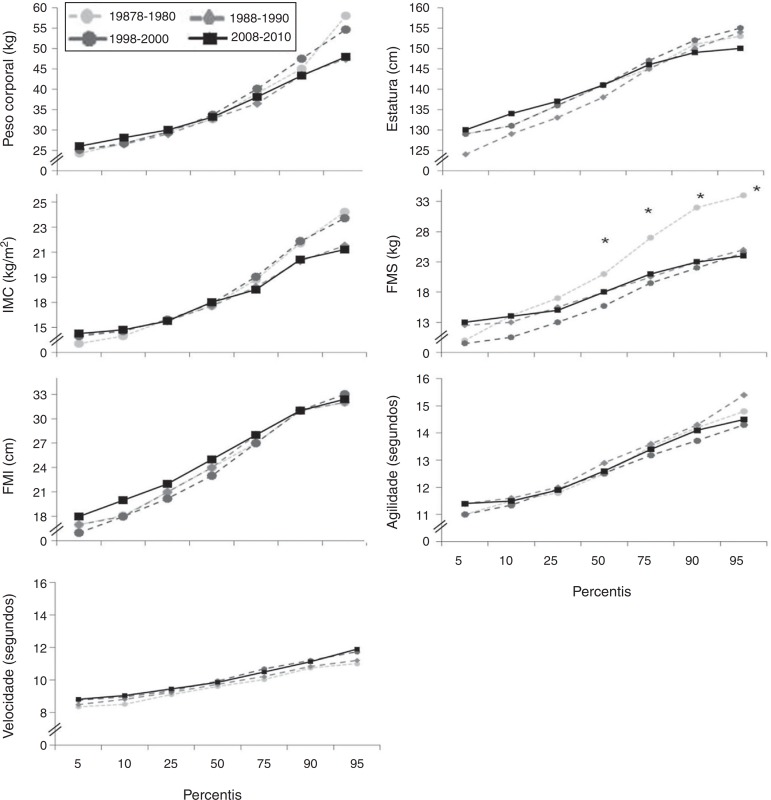
Valores de percentis para cada variável de aptidão física independentemente
do estado nutricional em 30 anos, no sexo masculino. FMS, força de membros
superiores; FMI, força de membros inferiores; *p<0,01: para
comparações entre linha de base com 10 anos, 20 anos e 30 anos.